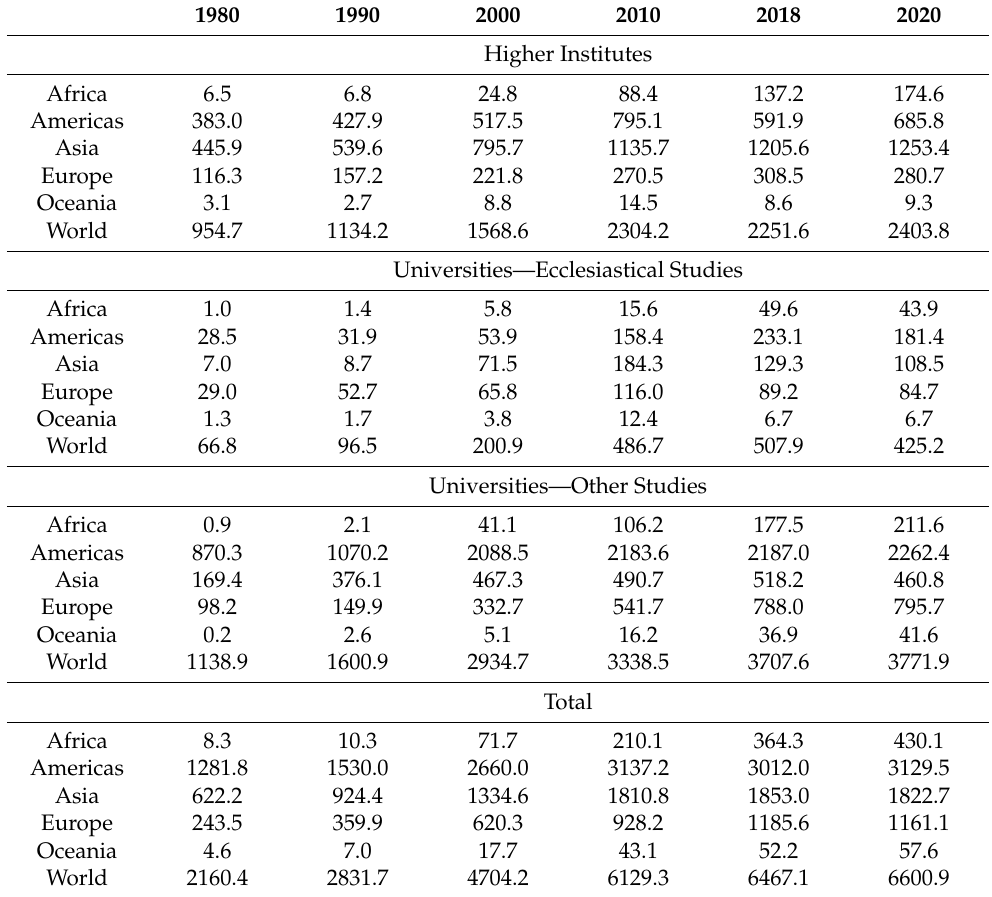
Table 1. Trends in the number of students enrolled in Catholic higher education